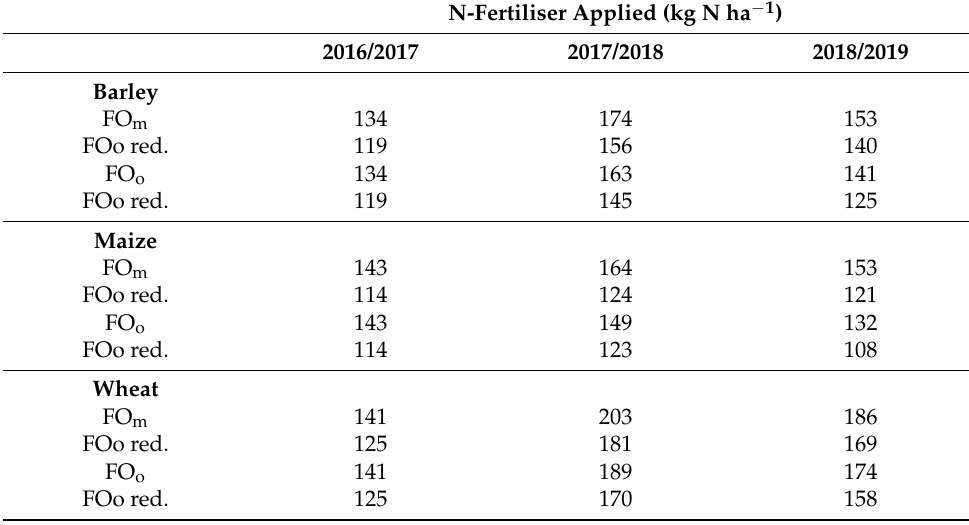
Table 1. Applied N-fertiliser rates for the fertiliser ordinance (FO) treatments within crop and year. (0 and 50kgNha − 1 treatments were constant in all